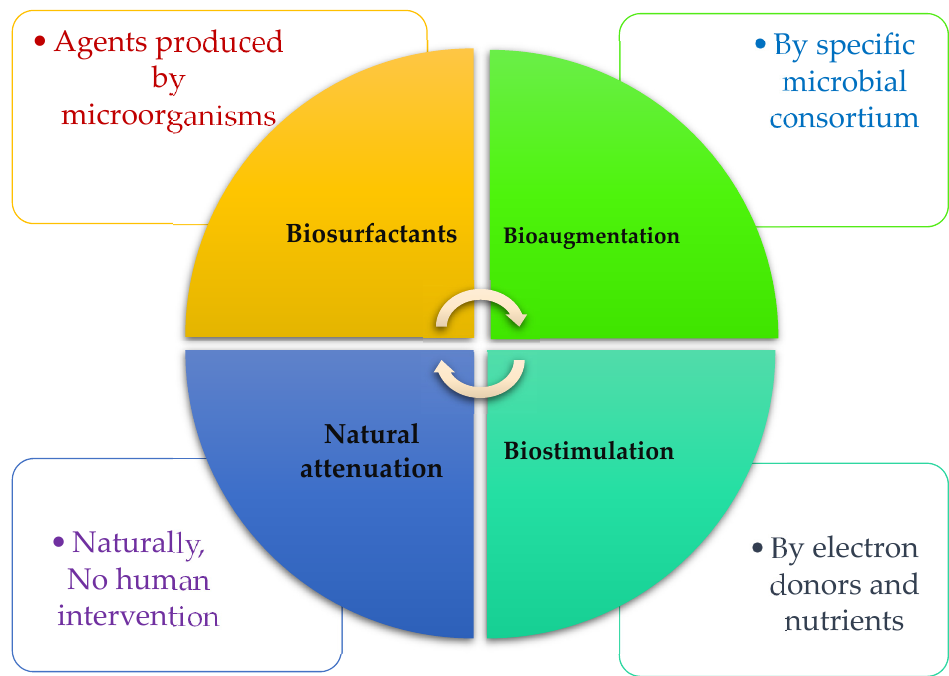
Figure 1. The most prevailing bioremediation techniques are used for HCs degradation.